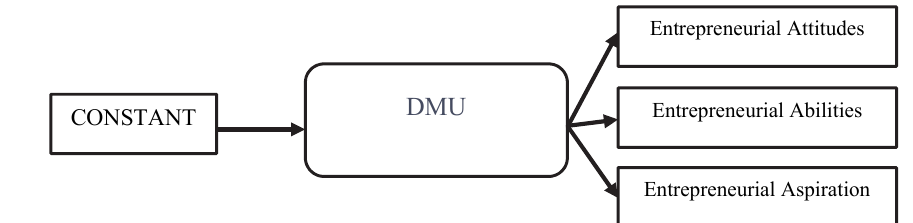
Fig. 1. Pure output-oriented Data Envelopment Analysis model for entrepreneurship